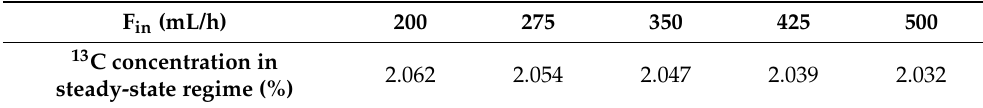
Table 2. Simulation results